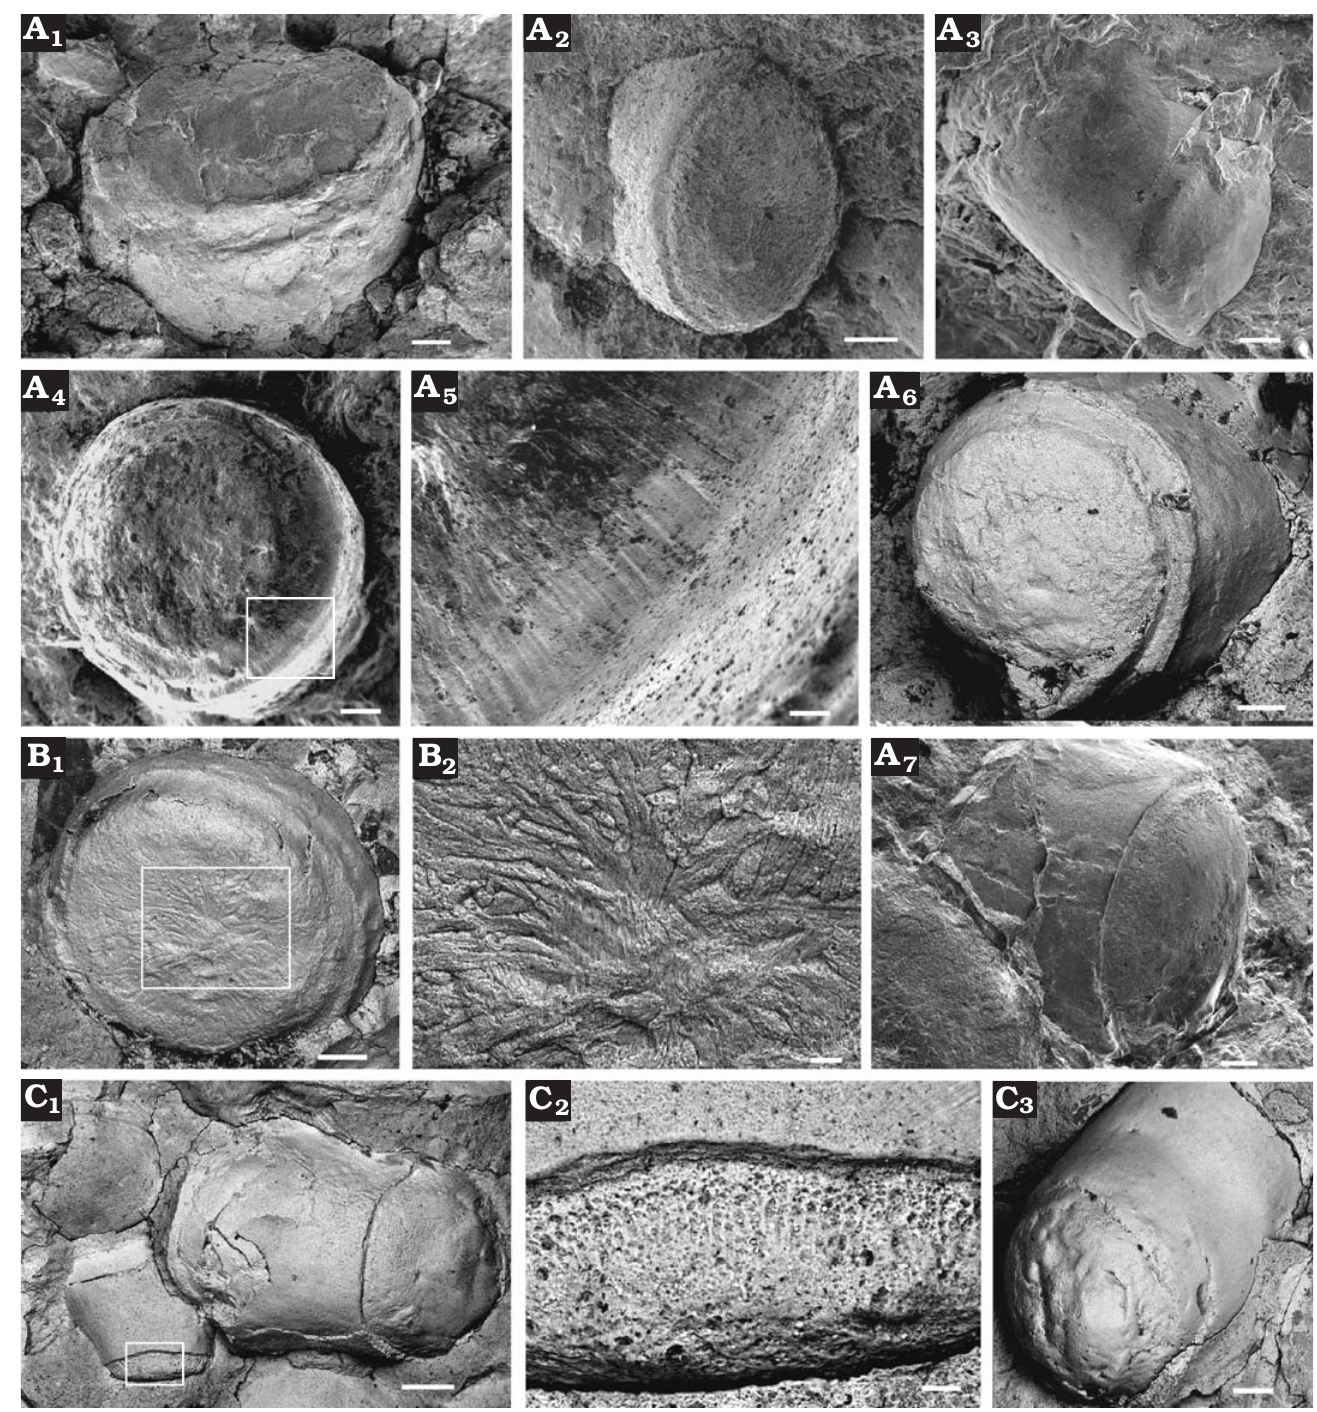
Fig. 5. Internal moulds of decollated segments of cupithecid hyolith Cupitheca convexa sp. nov. from the Manto Formation (Cambrian Stage 4/5) in the Zuo- jiawu section of Tangshan, China. A . NIGPAS 166334, discarded apical segments with smooth surface (A 1 –A 3 , A 6 ); bottom of the apex (A 4 ); apical bottom covered with radial sculptures (A 5 ); discarded segment preserves faint transverse lines on the surface of conch (A 7 ). B . NIGPAS 166343, decollated segment displaying apical bottom, probable diagenetic artefacts on the bottom of apex (B 1 ); branching ornamentation on the bottom of apex (B 2 ). C . NIGPAS 166339a, decollated segments two segments preserved together the left one exhibits pits and longitudinal groove structures on the surface of terminal part (C 1 ); detail (C 2 ); discarded apical segments with smooth surface (C 3 ). Scale bars: A 1 , A 3 , A 6 , A 7 , B 1 , C 3 , 100 μ m; A 2 , A 4 , 50 μ m; C 1 , 200 μ m; A 5 , B 2 , C 2 , 20 μ covered from proximal to distal terminations with scattered sub-circular pits (shown as tubercles on the counterparts; e.g., Fig. 6D), 4–9 μ m in diameter. Exterior of operculum is